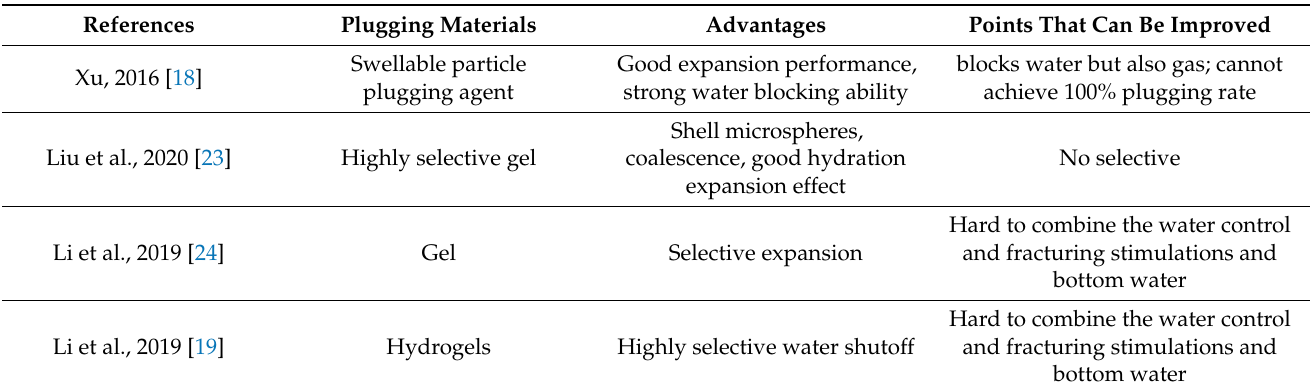
Table 1. Summary of partial plugging